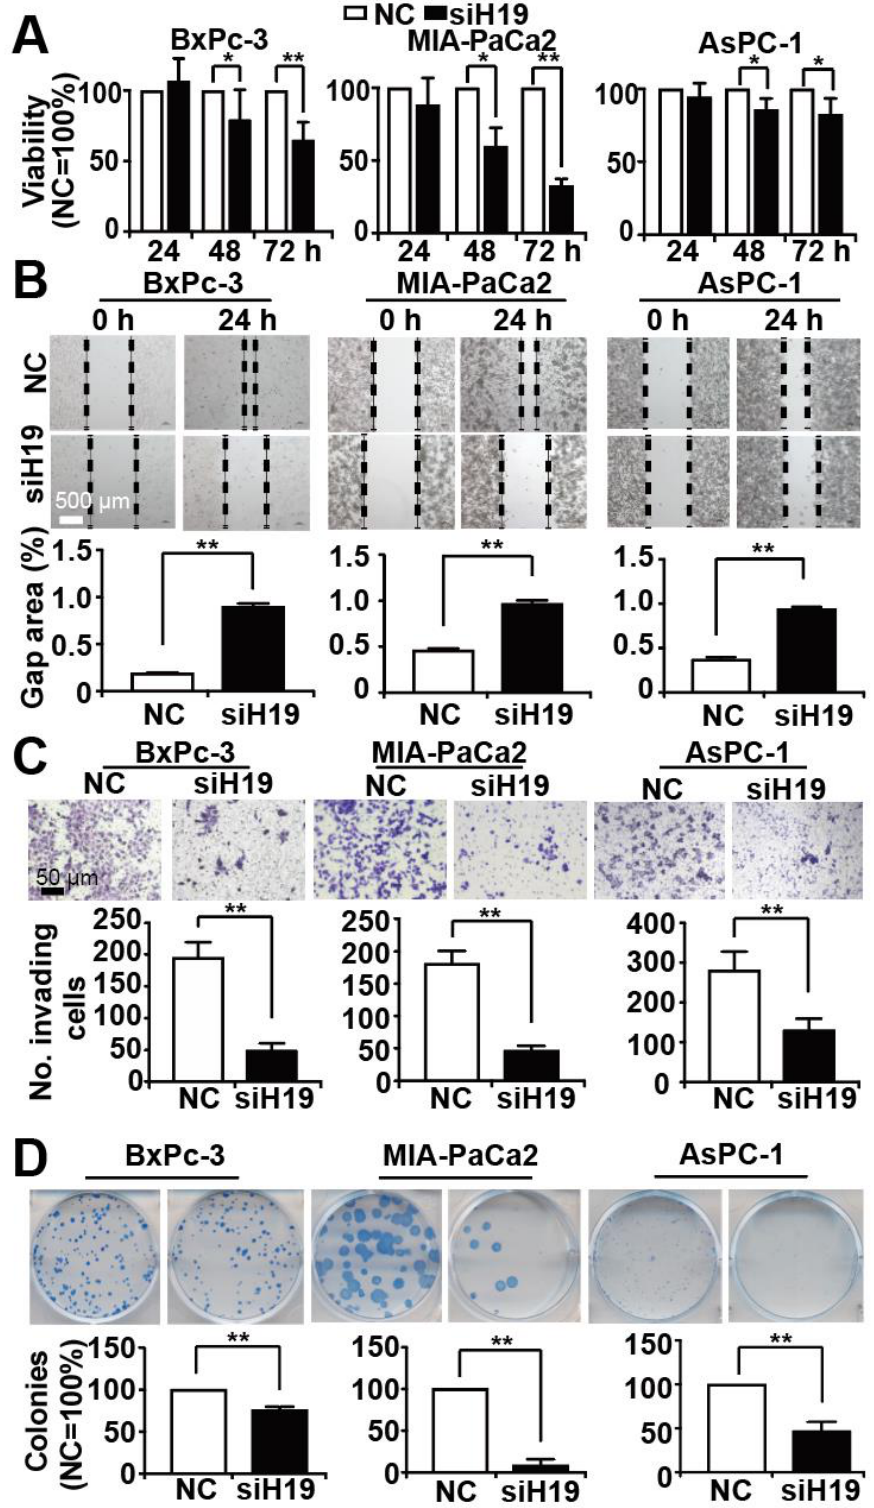
Figure 2. Knockdown of H19 inhibits tumor progression features. ( A ) BxPc-3, AsPC-1 and MIA- PaCa2 cells were transfected with H19 siRNA (siH19, black bars) or a nonsense siRNA control (NC, white bars), 20 µg each, using Lipofectamine 2000. Cell viability was detected by MTT assay at 24 h, 48 h and 72 h after transfection, and the data obtained with the nonsense siRNA controls of each cell line were set to 100%. ( B ) Twenty-four hours after lipo-transfection, the cells were seeded onto 6-well plates. After reaching 90% confluency 24 h later, a scratch was made to the middle of the cell layer